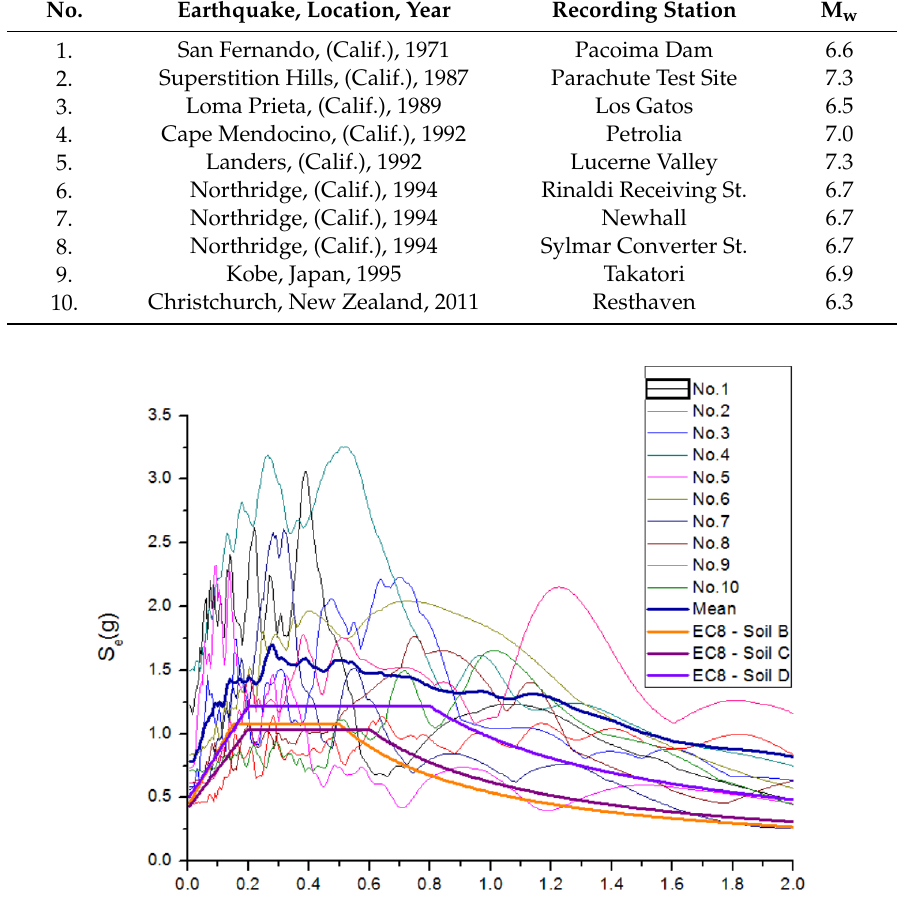
Figure 3. Response spectra of the accelerograms of Table 3 and of Eurocode 8